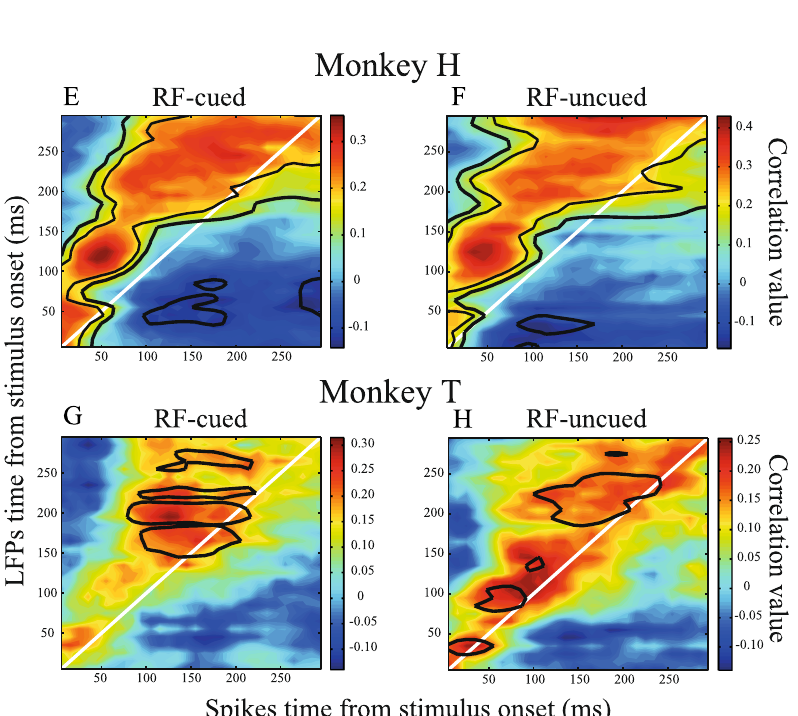
Figure 3. Correlation map across spiking activity & LFP time bins. ( A – D ) The top panels (A,B) represent the correlation maps for the two monkeys. X and Y-axes represent the center of the 10 ms time bins (aligned to stimulus onset) for spiking activity and LFP averaging, respectively. For each pair of time bins, colors show the average Pearson correlation of spiking activity and LFP calculated per site across trials with the preferred stimulus. Black borders indicate regions that have statistically significant correlations across recording sites (thicker borders correspond to p < 0.01 (t-test, corrected for multiple comparisons)). White lines connect pairs of time bins with the same X and Y indices and are drawn for illustration. Panels (C,D) present the histogram of “LFP time index – Spikes time index” for the time pairs with significant correlations for each monkey. The dashed vertical lines correspond to the median of each histogram ( + 40 ms for both monkeys, p ≪ 0.001, sign test). ( E – H ) Correlation maps for different cueing conditions. ( E , G ) Similar to maps in panels (A,B) but for trials in which the RF location was cued and therefore the stimulus inside the RF (moving in the preferred direction) was the target. ( F , H ) Correlation maps for trials where the cue was contralateral to the RF, i.e.